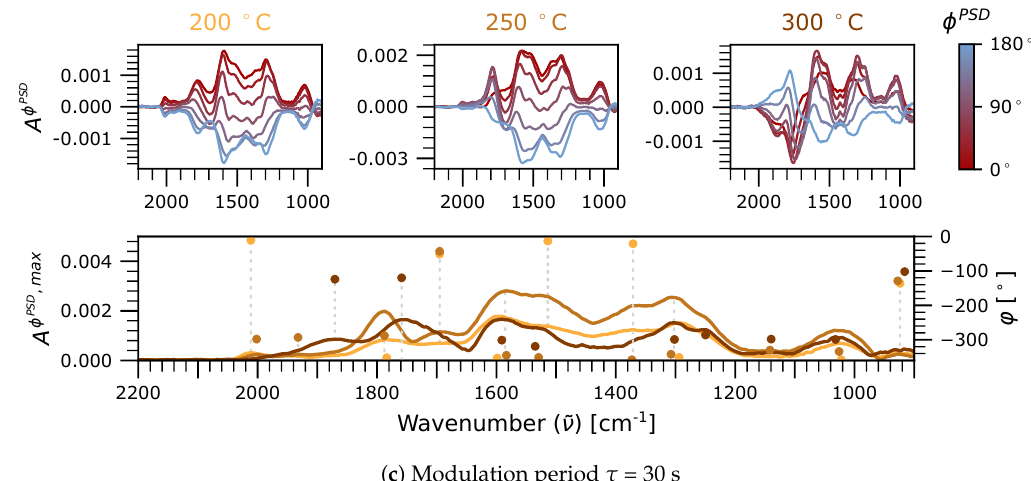
Figure 3. Graphical representation of phase sensitive detection (PSD) analysis results for CO 2 hydrogenation over Rh/CeO 2 at 200, 250, and 300 ◦ C and different H 2 modulation period lengths ( τ ) of 120, 60, and 30 s (a, b and c respectively). Top rows: PSD plots showing amplitude ( A φ PSD ) versus wavenumber for demodulated spectra within 0 ◦ ≤ θ PSD ≤ 180 ◦ . Bottom rows: Composite plots showing maximum amplitude ( A φ PSD , max ) at each wavenumber in the period of 0 ◦ ≤ θ PSD ≤ 360 ◦ (